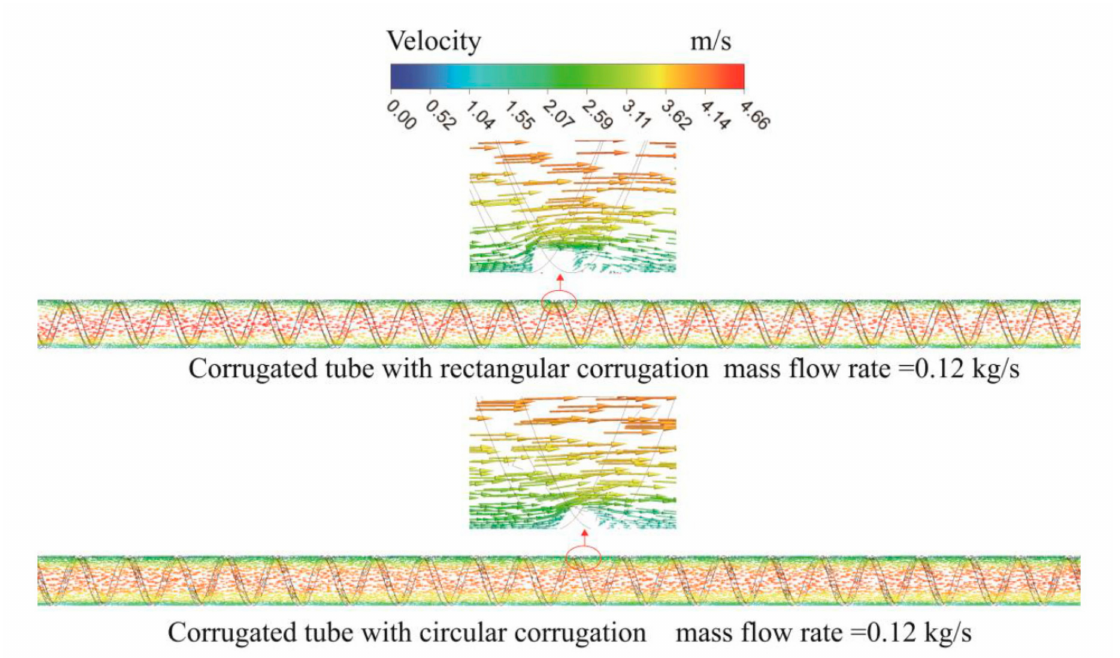
Figure 10. Velocity of the fluid flow in corrugated tubes with circular and rectangular